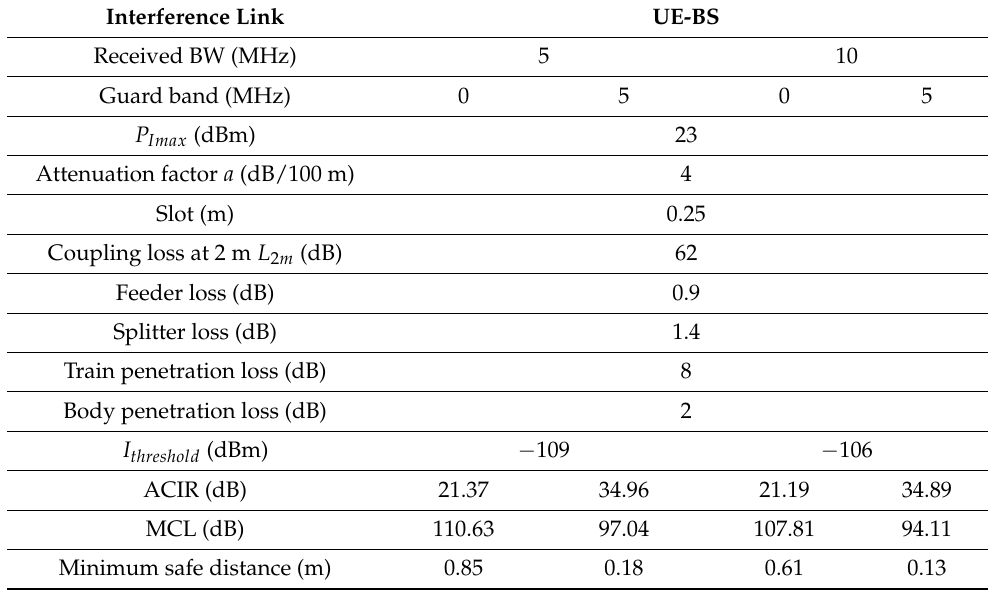
Table 6. Interference calculation parameters of LTE-M with leaky cable radiations pattern.